Question: Provide a one-line summary of what is displayed.
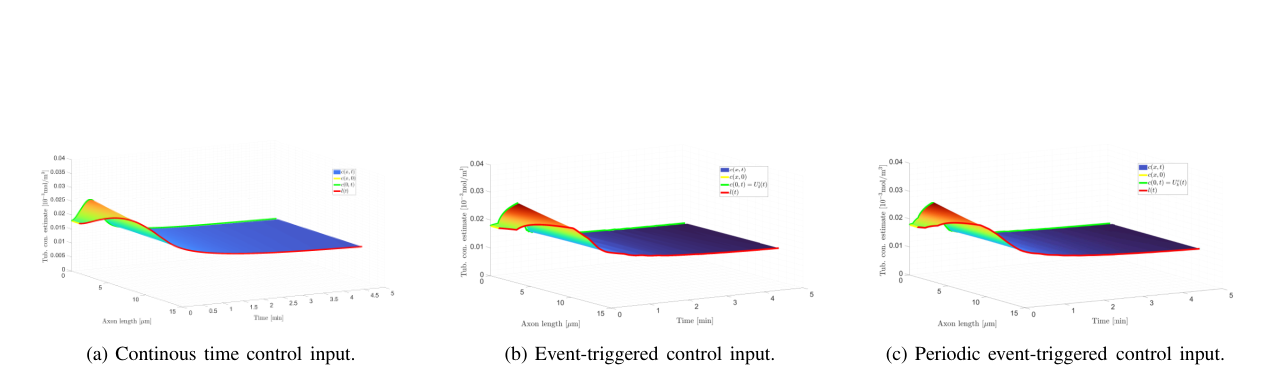
Answer: The tubulin concentration governed by (1)-(5), c(x, t), converges to the steady-state tubulin concentration, ceq(t) by about t = 4.5min for both continuous control input, CETC and PETC. The axon length, l(t), also converges to the desired axon length, ls, by about t = 4min for all sampling mechanisms.